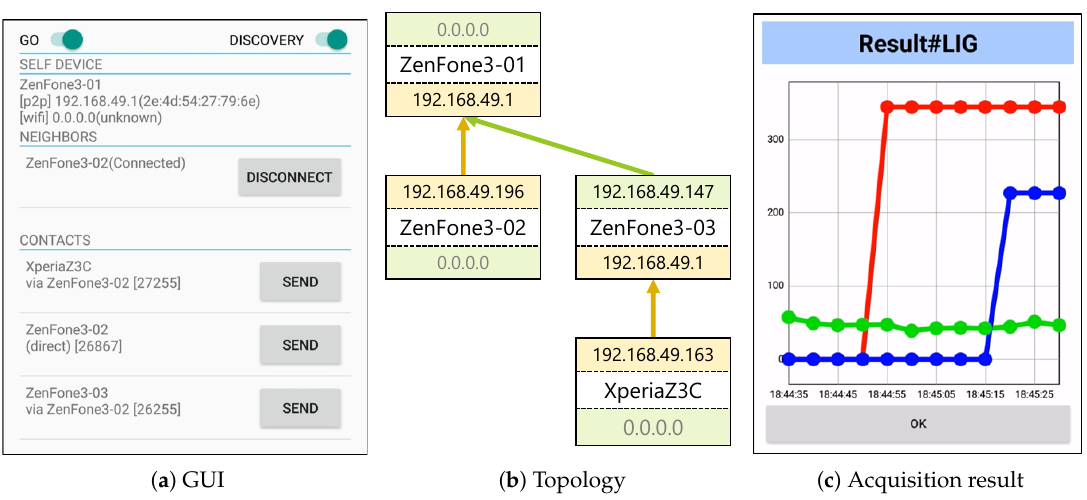
Figure 7. Example of running